Question: Sum up the contents of this chart in one sentence.
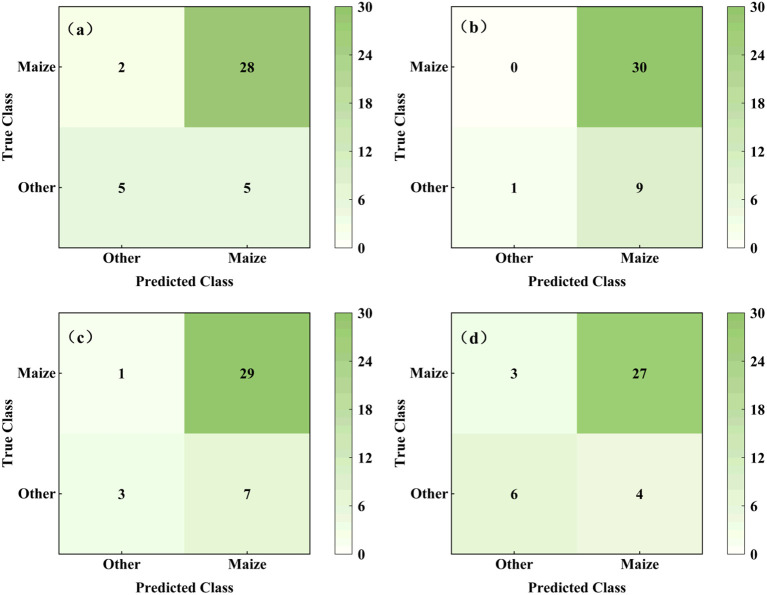
Answer: Confusion matrix evaluation of the models. (A) Random Forest (RF); (B) Extra Trees (ET); (C) Gradient Boosting Decision Trees (GBDT); (D) Histogram-Based Gradient Boosting Decision Tree (HGBDT).